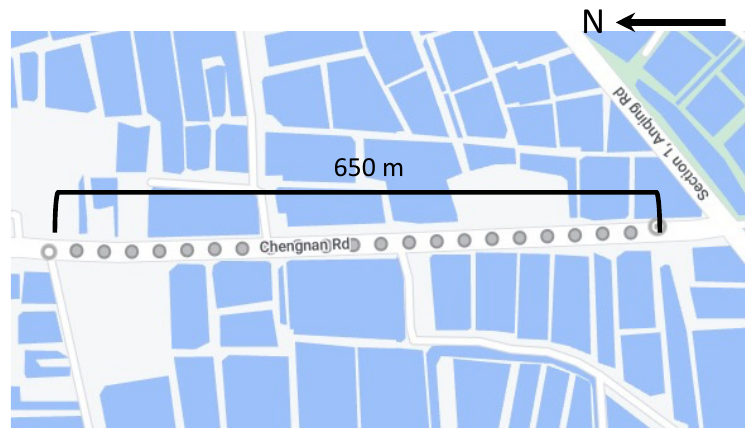
Figure 13. LIP experiment field (in Annan district, Tainan City, Taiwan).